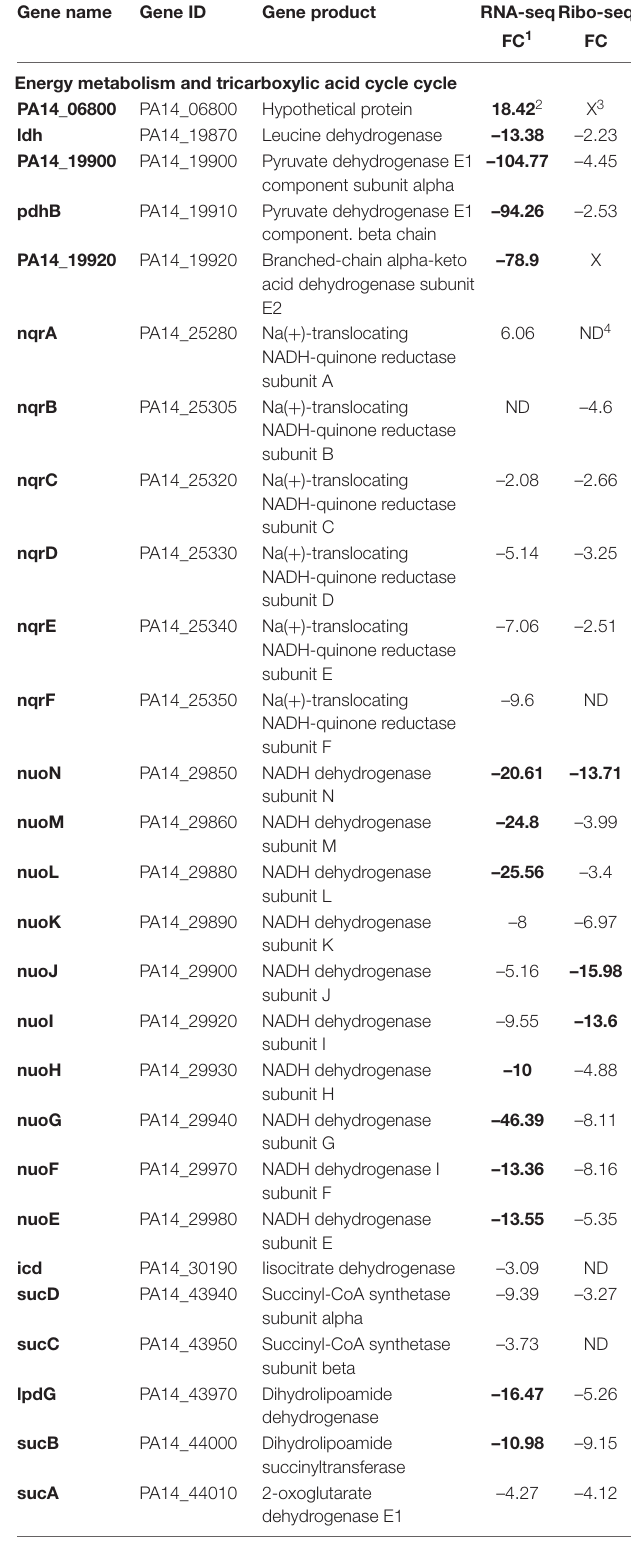
TABLE 2 | Gene expression response of PA14 grown in the presence of tobramycin versus untreated